Question: Author a descriptive caption for the visualization shown.
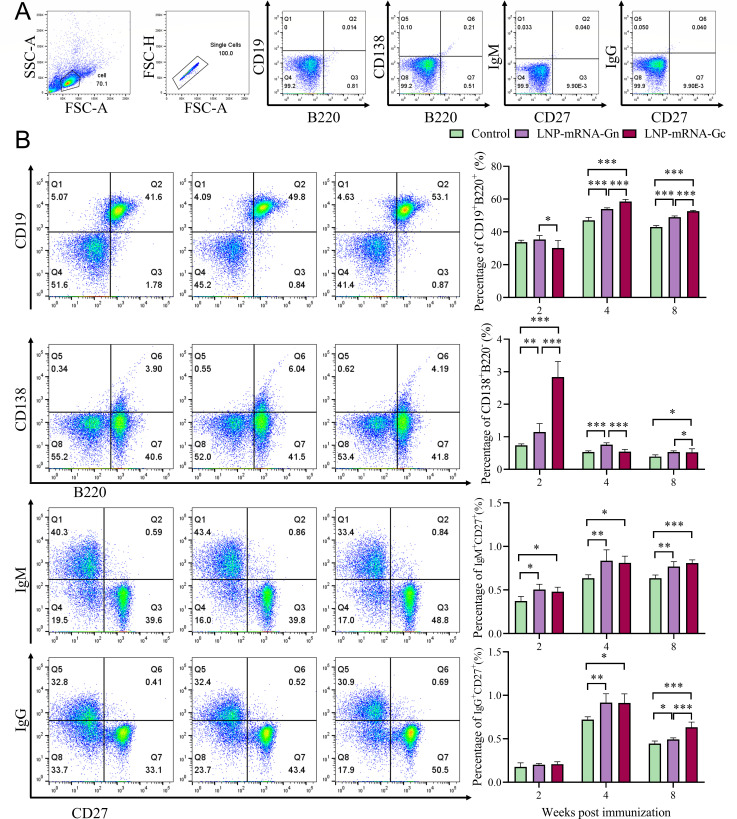
Answer: Activation of B cells in the spleen. ( A ) Gating strategies for analyzing B cells. ( B ) Spleens were collected at 2, 4, and 8 weeks postimmunization. Single-cell suspensions were prepared and stained separately with antibodies against B cells (CD19 + , CD138 + , CD27 + , B220 + , IgG + , and IgM + ). A representative flow cytometric plot of activated B cells is shown. Statistical analysis of the percentages of activated B cells in the spleen (15 wild-type mice per group; 5 mice per group per time point; values are means ± SEM; ANOVA with Tukey’s multiple comparisons test). * P < 0.05, ** P < 0.01 and *** P < 0.001.